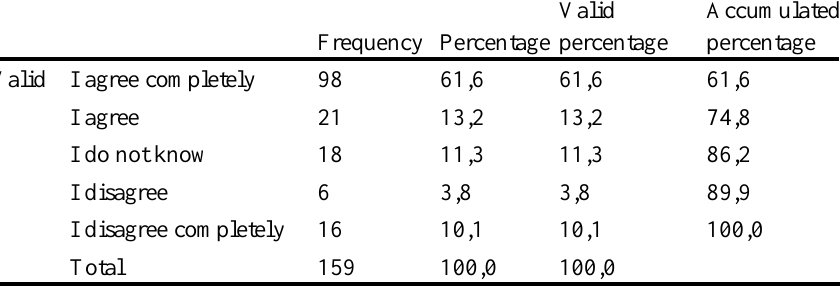
Valid percentage questionnaires´ results, question 4 “Students approve learning science subjects within the bilingual